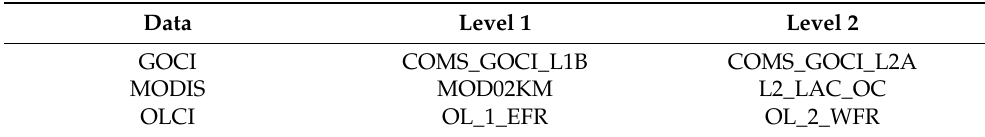
Table 2. Product